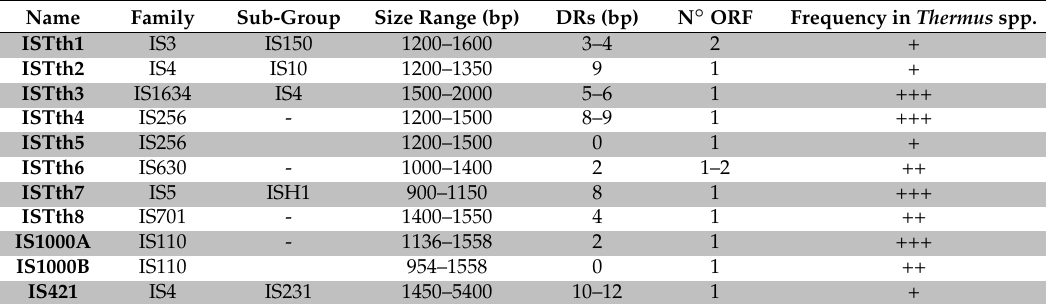
Table 2. Diversity of insertion sequences (ISs) across Thermus spp. Most relevant ISs found were characterized by the family and subgroup to which they belong, their main features (size, direct repeats (DRs), and number of ORFs), and their relative frequency among members of the genus Thermus . Frequency was graded as high (+++; present in more than 6 different isolates), moderate (++; present in 3–6 isolates) and low (+; present in 2 or fewer isolates). Presence across the genus was determined by BLASTn, with a threshold of E-value <10 − 10 , query coverage >40%, and identity